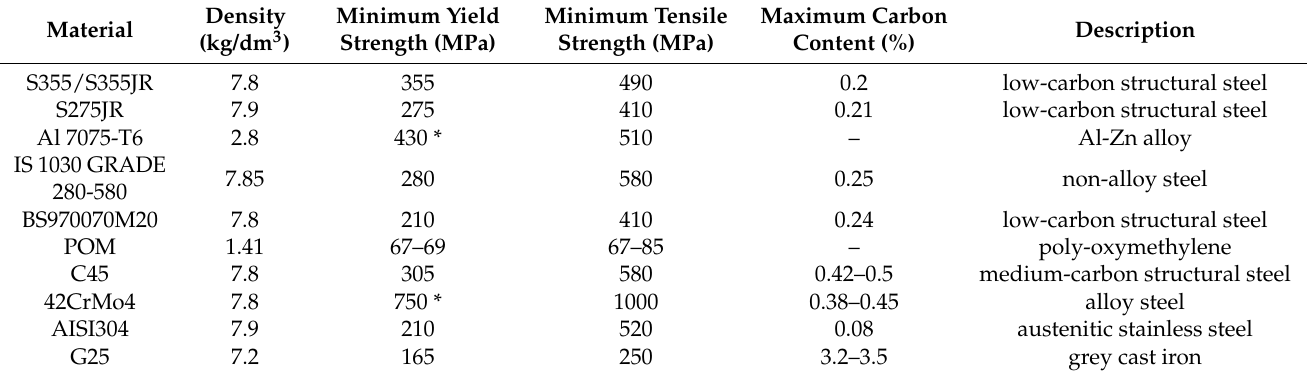
Table 7. Basic properties of the discussed materials used for bottoms and glands.